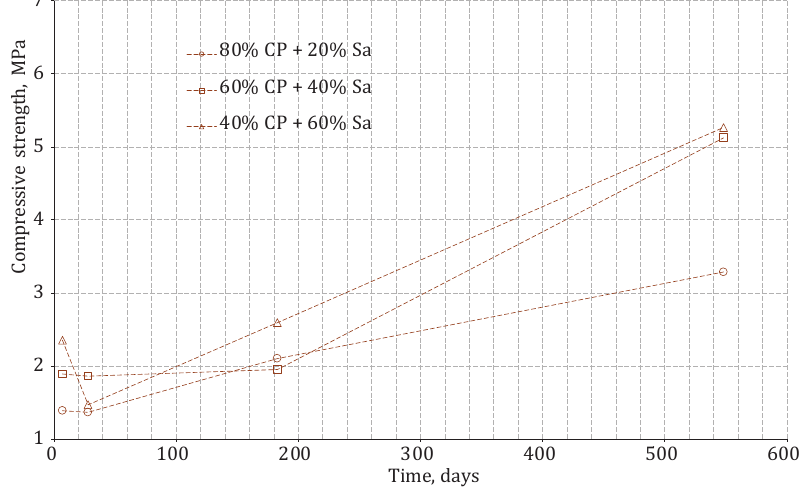
Figure 12. Updated compressive strength of samples (60% Portland cement + 40% fly ash) after Zakarka et al.